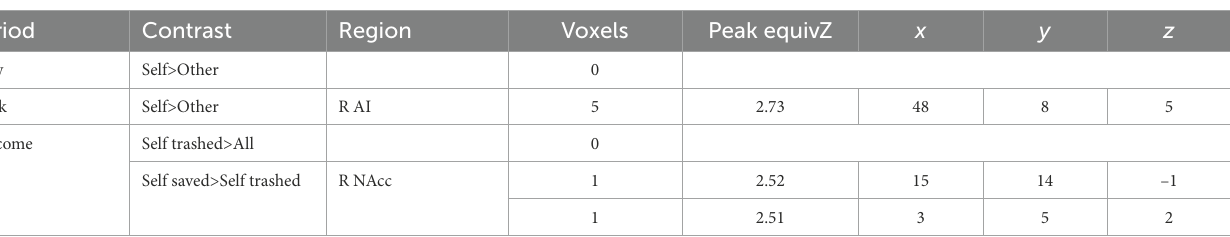
TABLE 1 ROI contrasts, per period, with the 2 × 2